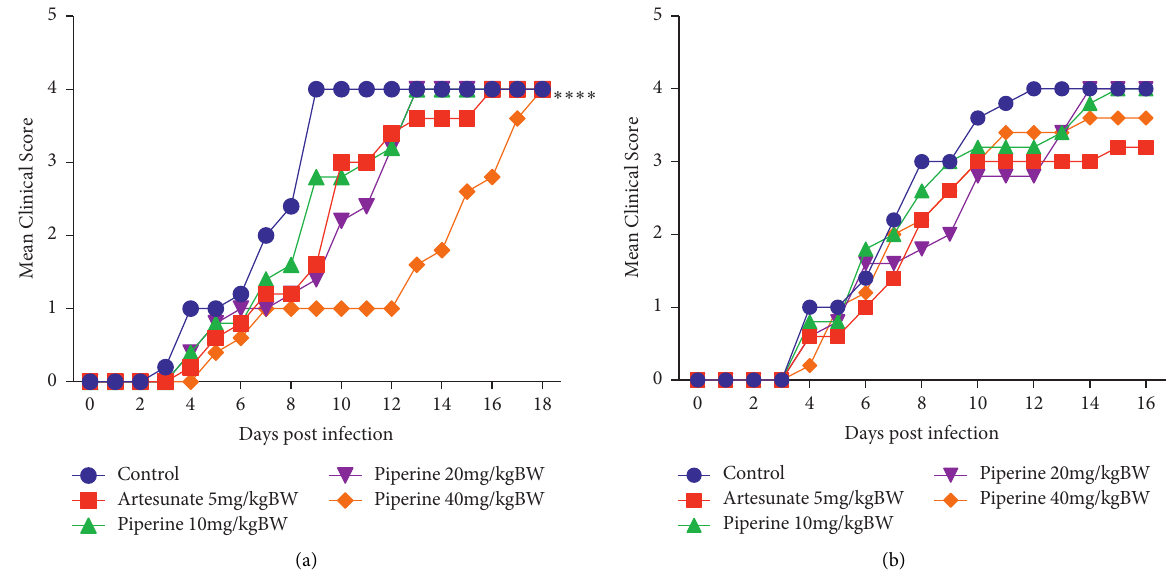
Figure 5: Effect of piperine administration on the clinical score of mice infected with P. berghei ANKA in the (a) curative test and (b) prophylactic test. Data are presented as mean ± SEM. ∗∗∗∗ p < 0 . 0001 compared with negative control (two-way ANOVA followed by Tukey’s post hoc